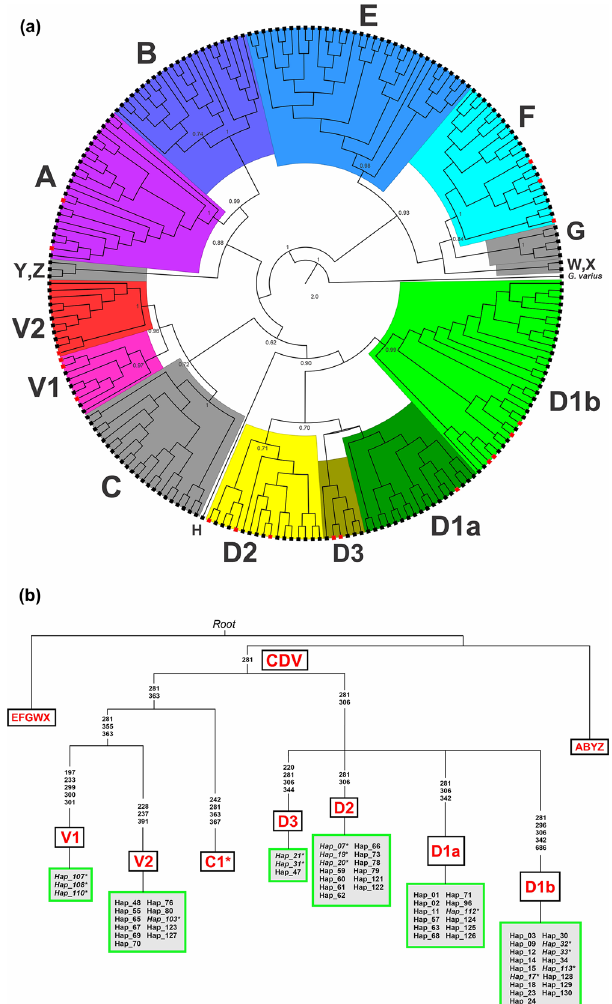
Figure 1. ( a ) Bayesian phylogenetic tree of complete mtDNA D-loop nucleotide sequences of Southeast Asian and Pacific chickens. The tree was constructed together with database sequences defined by Huang et al. 31 (Supplementary Table S4). Node labels correspond to posterior probability support values. Identified haplogroups are assigned with color codes, while grey color is assigned for reference haplogroup nomenclatures with no classified samples. Tips highlighted in red indicate red junglefowl. ( b ) Schematic classification tree showed reclassified macrohaplogroup CDV. The nucleotide positions were scored relative to the reference sequence NC_040970. Mutational motifs (transitions) are shown on the branches. Haplotypes in italics and asterisk indicate red junglefowl. Tree file was visualized and edited in FigTree v1.4.4. (http:// tree. bio. ed. ac. uk/ softw are/ figtr